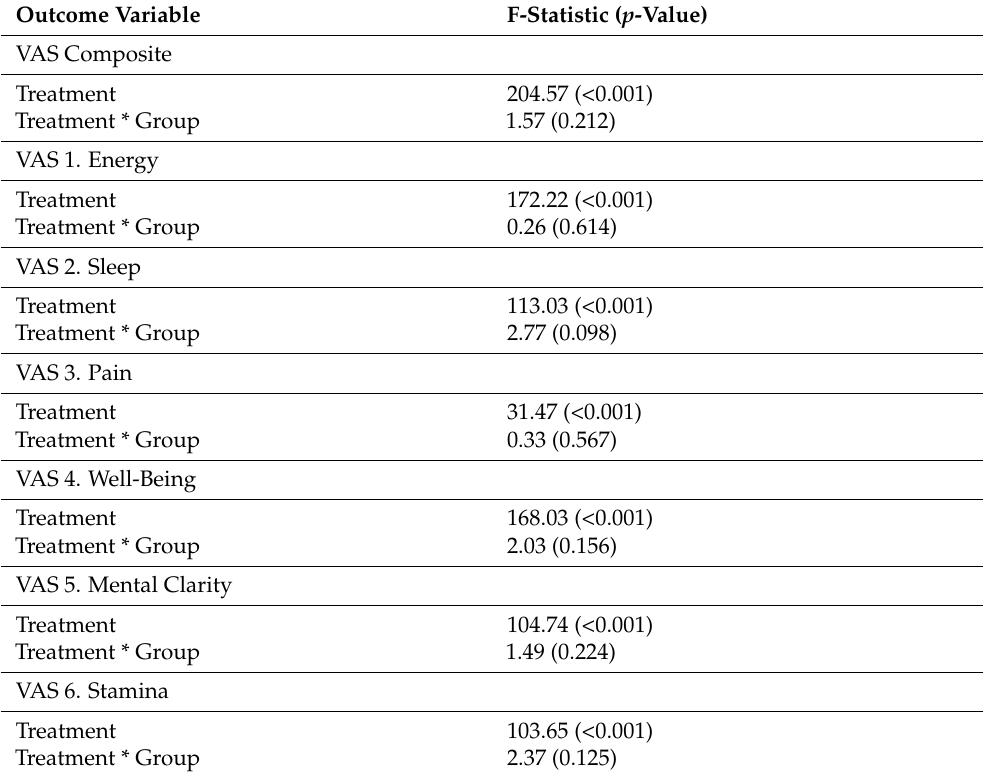
Table 4. Results of Mixed Model ANOVAs Examining Change in Primary and Secondary Outcomes by Illness Onset Status (N = 188).